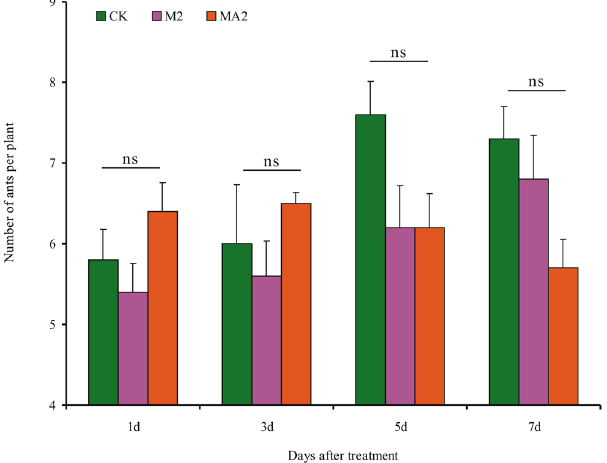
Figure 6. Responses of patrolling ants to plants with ant-tended mealybugs (experiment 4). Patrolling ants (ca. 200 ants) were present in all three treatments and could move up the plant to the petioles but could not move onto the leaf blades because the petioles were coated with petrolatum. In treatment MA2, ants in the rearing case (ca. 100 ants) had access to the leaf blades with mealybugs (60 individuals per plant). For treatment M2, leaf blades had mealybugs but no ants. In the control (CK), there were no ants or mealybugs on the leaf blades. Numbers of patrolling ants per plant were determined at 1, 3, 5, and 7 d after the mealybugs were placed on the leaves. Values are the means ( + SE) of five replicates. The effects of treatment, observation time, and their interaction were not statistically significant ( P > 0.05).